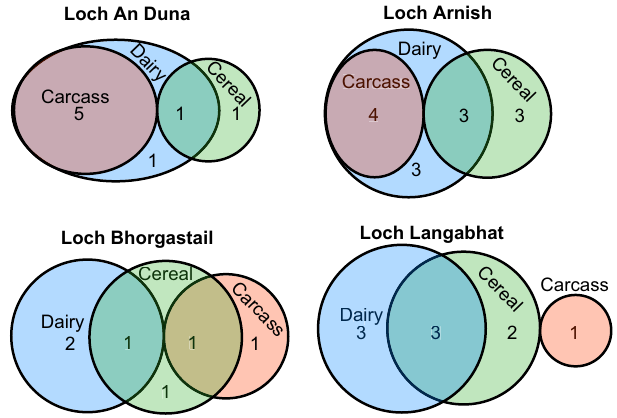
Fig. 5 | Venn Diagrams showing the distribution and mixing of ruminant car- cass (red) and dairy fat (blue) as well as cereal lipids (green) in lipid extracts from Loch an Duna, Loch Arnish, Loch Bhorgastail and Loch Langabhat. Sizes of the ellipses correspond with relative proportions of the commodity for each individual site and numbers denote the absolute number of samples with lipid signaturescharacteristicforthisrespectivecommodityorcombinationsoftheseat each site. This illustrates the absence of mixing of carcass and dairy products in potsfromLochsBhorgastailandLangabhat,unliketheirfrequentco-occurrencein samples from Loch an Duna and Loch Arnish, and the overall very rare co- occurrence of cereal biomarkers with carcass (meat) products. Source data are provided as a Source Data fi